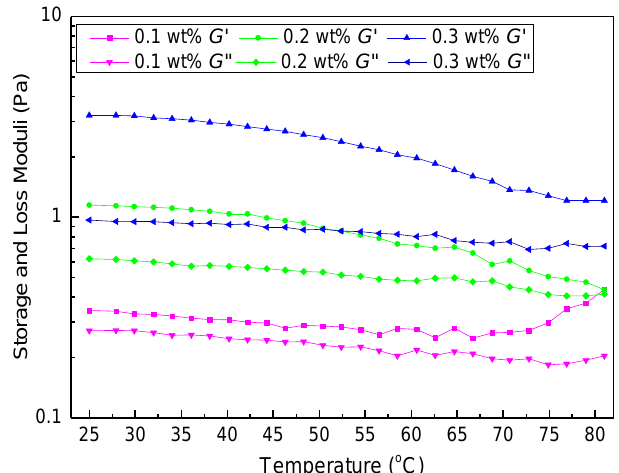
Figure 12. The G’ and G’’ as a function of temperature for tested fluids.